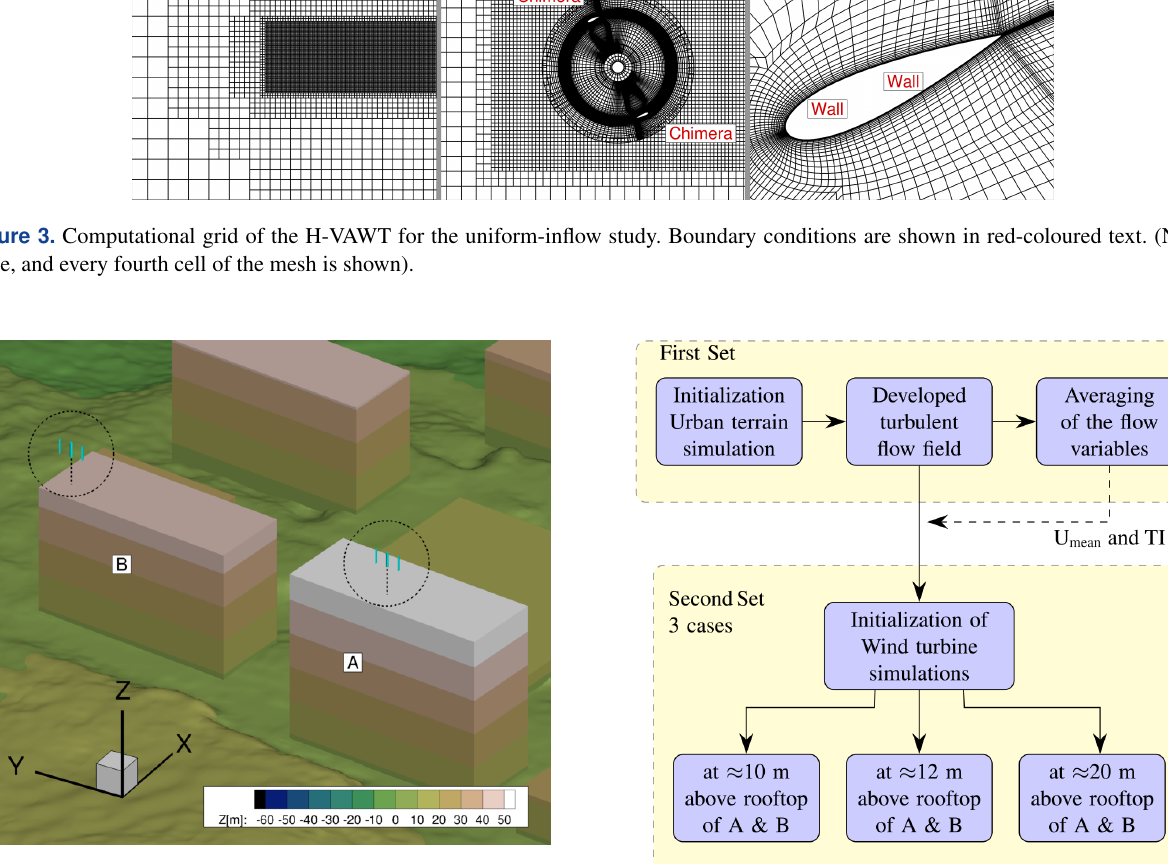
Figure 4. Rooftop-mounted H-VAWTs on top of buildings A and B. Figure 5. Computational approach for the investigation of VAWTs in urban terrain under turbulent-inflow